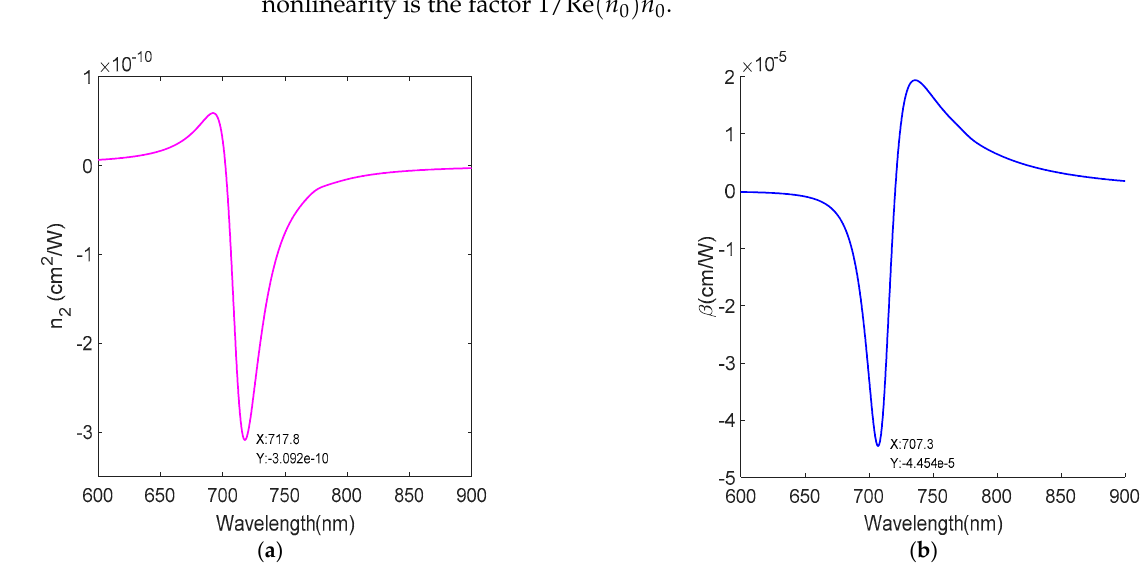
Figure 9. Nonlinear coefficient without the gain medium. ( a ) Nonlinear refraction index n 2 . ( b ) Nonlinear absorption coefficient β . Table 1. Comparisons of the third-order nonlinear optical coefficients of different